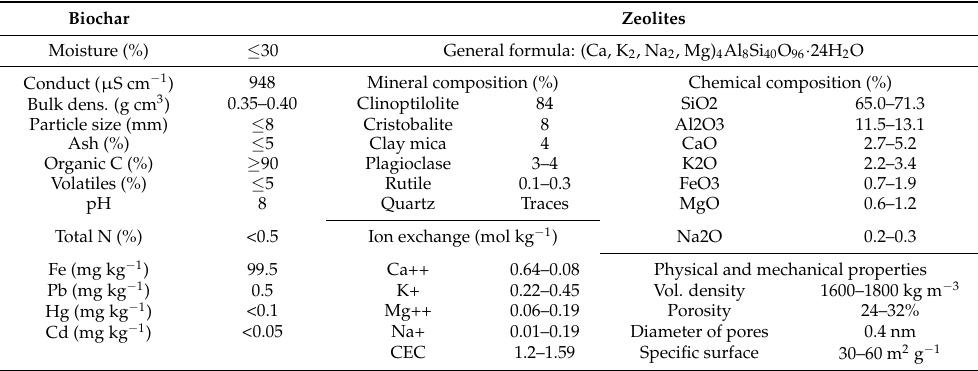
Table 2. Selected properties of biochar and zeolites used in the experiment (data provided by the